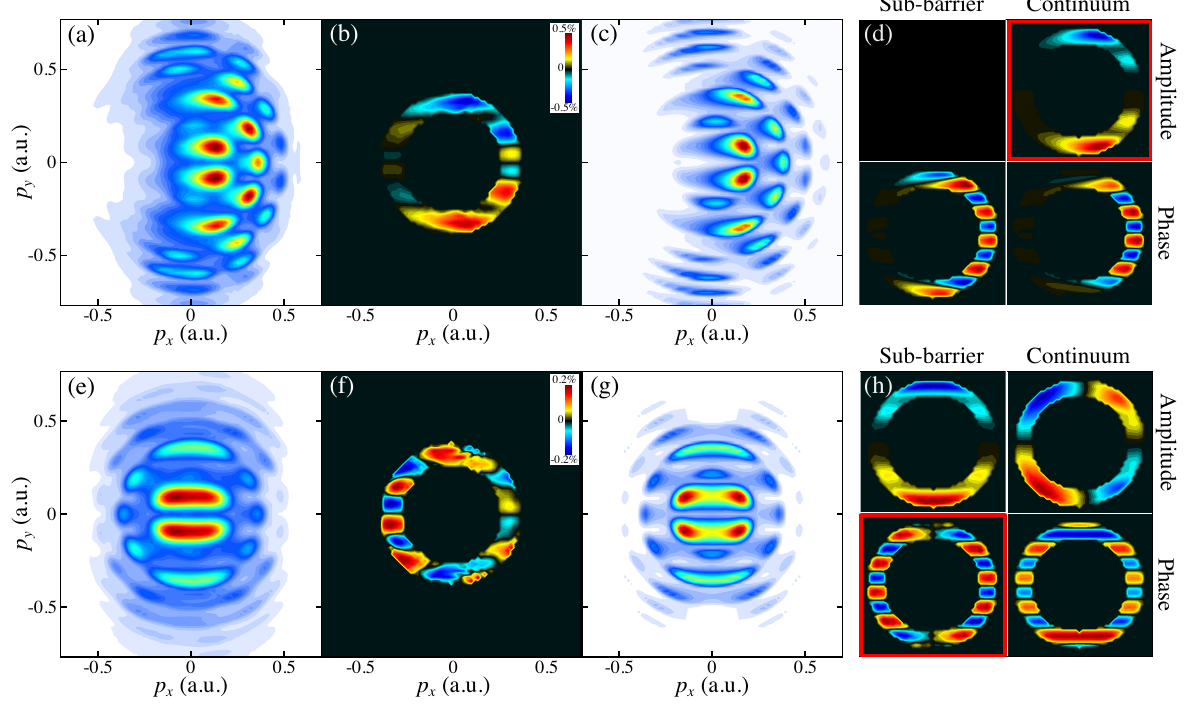
FIG. 6. (a) Projected PAD P ð p x ; p y Þ obtained by TDSE calculations when the Yukawa-screened toy molecule is ionized by an 8-shaped OTC field with I ω ¼ 5 × 10 13 W · cm − 2 and r ¼ 0 . 1 . (b) Projected forward-backward asymmetry Δ P f=b ð p x ; p y Þ resulting from TDSE calculations, restricted to the second ATI peak and normalized to the maximal value of P ð p x ; p y Þ . (c) SFA counterpart to the TDSE projected PAD. (d) Chiral-SFA asymmetries assuming different sources of chiral response. The TDSE asymmetry in the second ATI signal mainly stems from continuum amplitude effects. (e) – (h) are identical to (a) – (d) but relative to a C -shaped field. The TDSE asymmetry is mainly due to a sub-barrier chiral phase in that